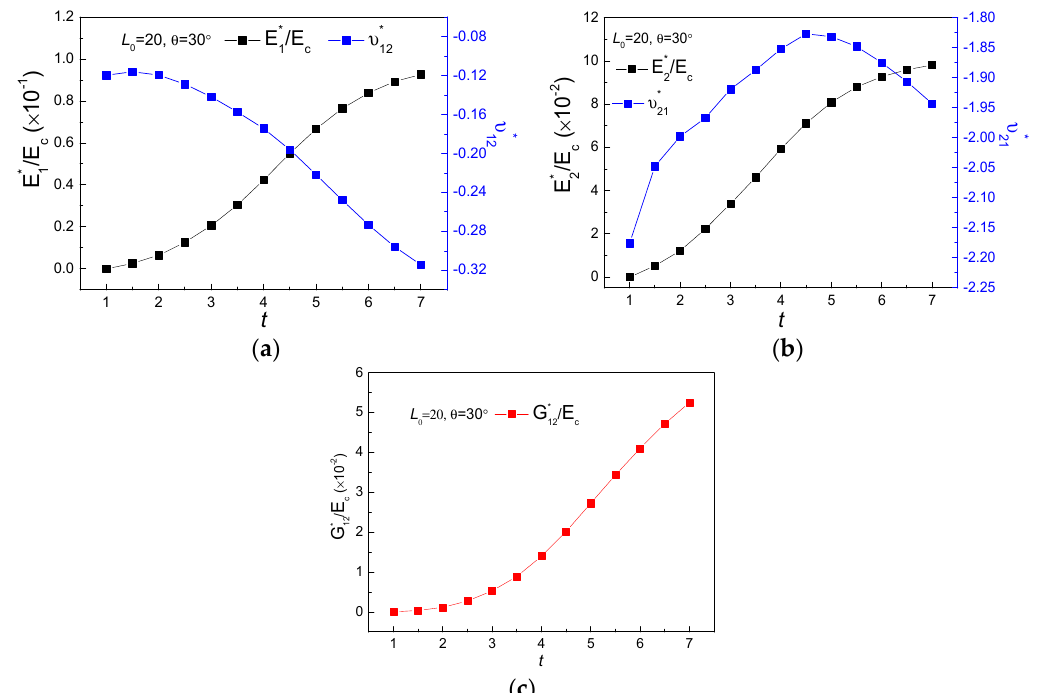
/ E c and ν ∗ , ( b ) E ∗ / E c t 2 1 12 : ( a )